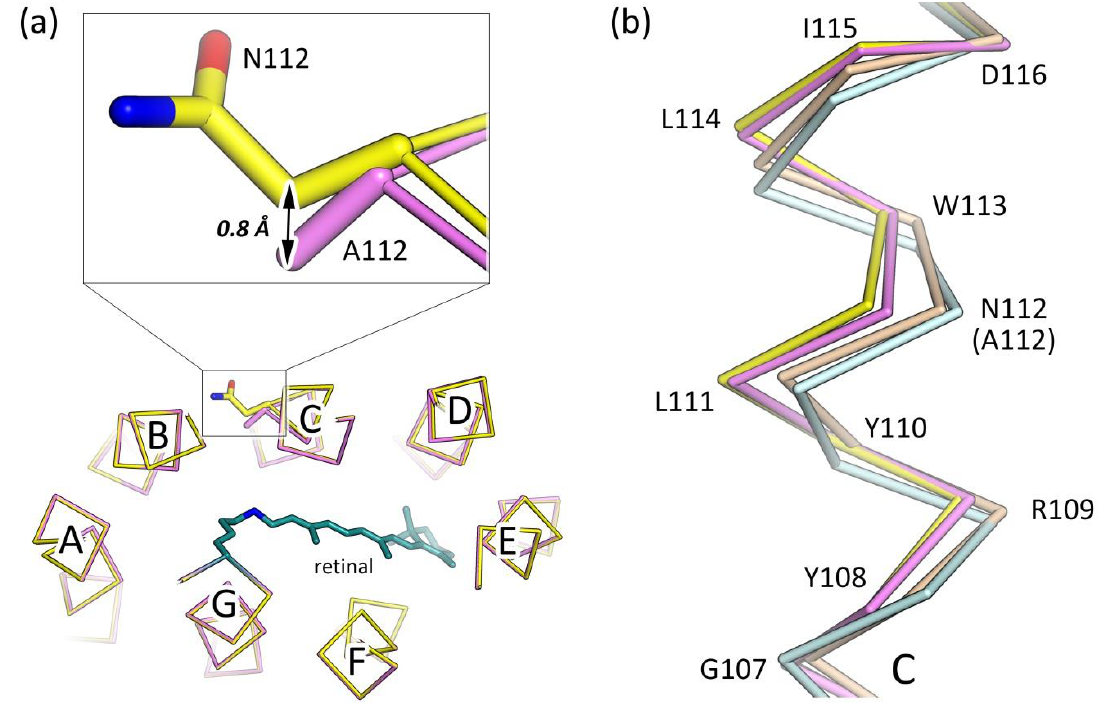
Figure 2. Deflection of the helix C in the N112A mutant of KR2. ( a ) Displacement of the Cβ atoms of A112 and N112 of the N112A and WT KR2 structures, respectively. The 0.8 Å shift towards the inside of the KR2 protomer is shown with a black arrow. The retinal cofactor is colored teal. ( b ) Side view of the structural alignment of the helix C of the “expanded” conformation of the WT KR2 (yellow, PDB ID: 6YC3 [41]), KR2-N112A (violet, PDB ID: 6YT4, present work), “compact” conformation of the WT KR2 (light-orange, PDB ID: 4XTN, chain I [2]), and monomeric form of the WT KR2 (light-cyan, PDB ID: 4XTL